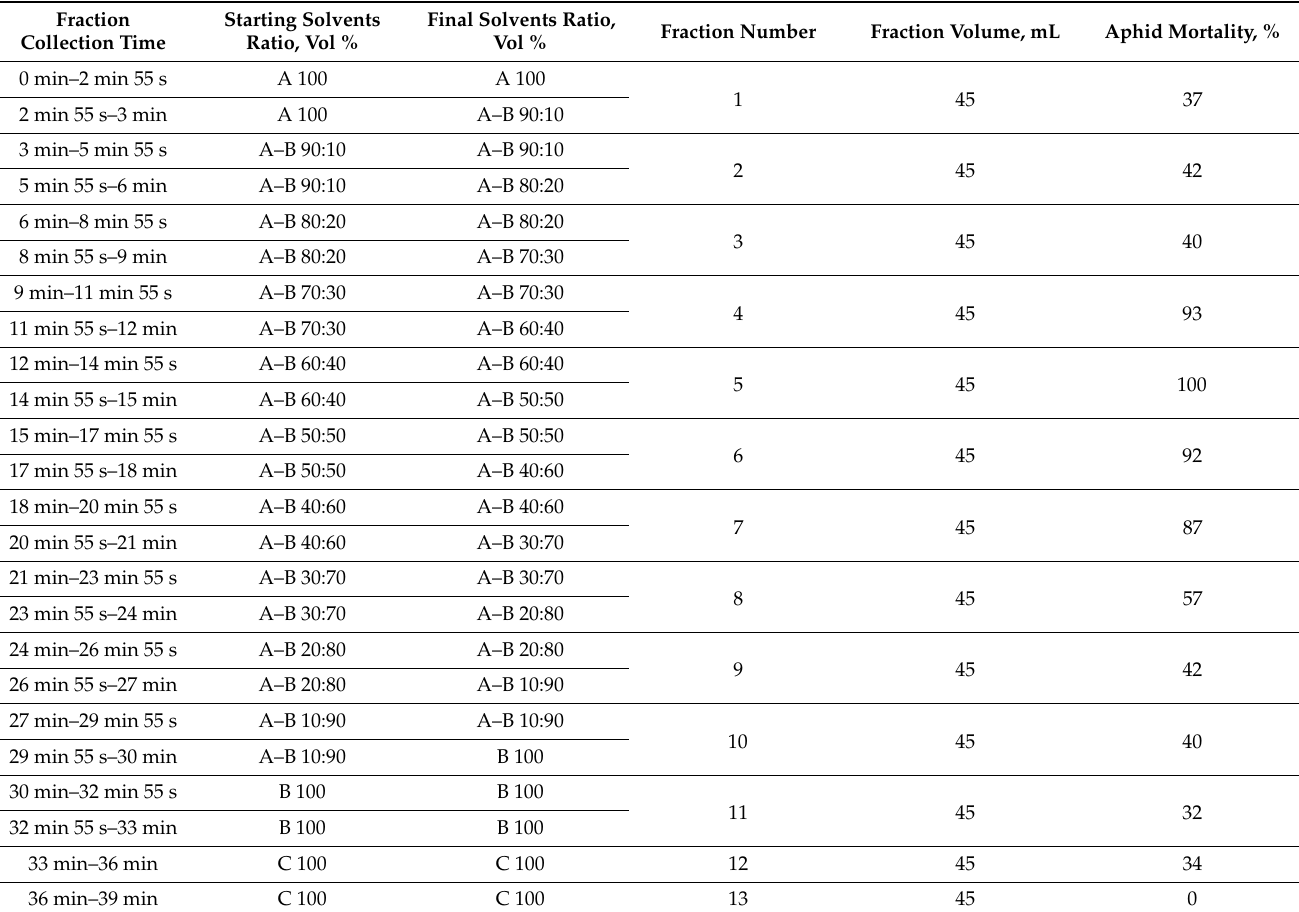
Table 3. Chromatographic mode and procedure for selection of the fractions having insecticidal activity against Medoura viciae